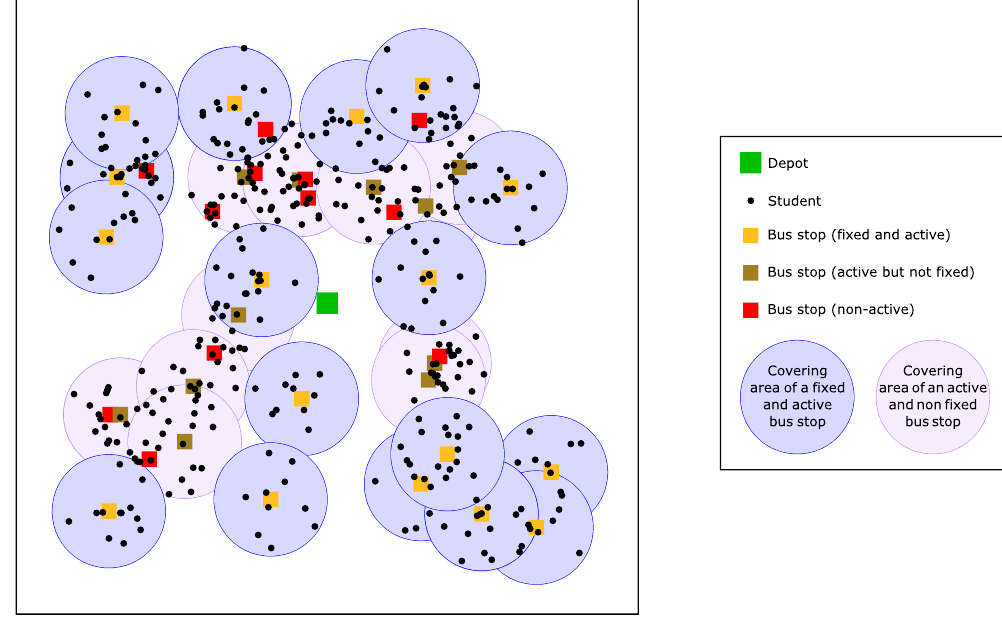
Figure 3. A covering of